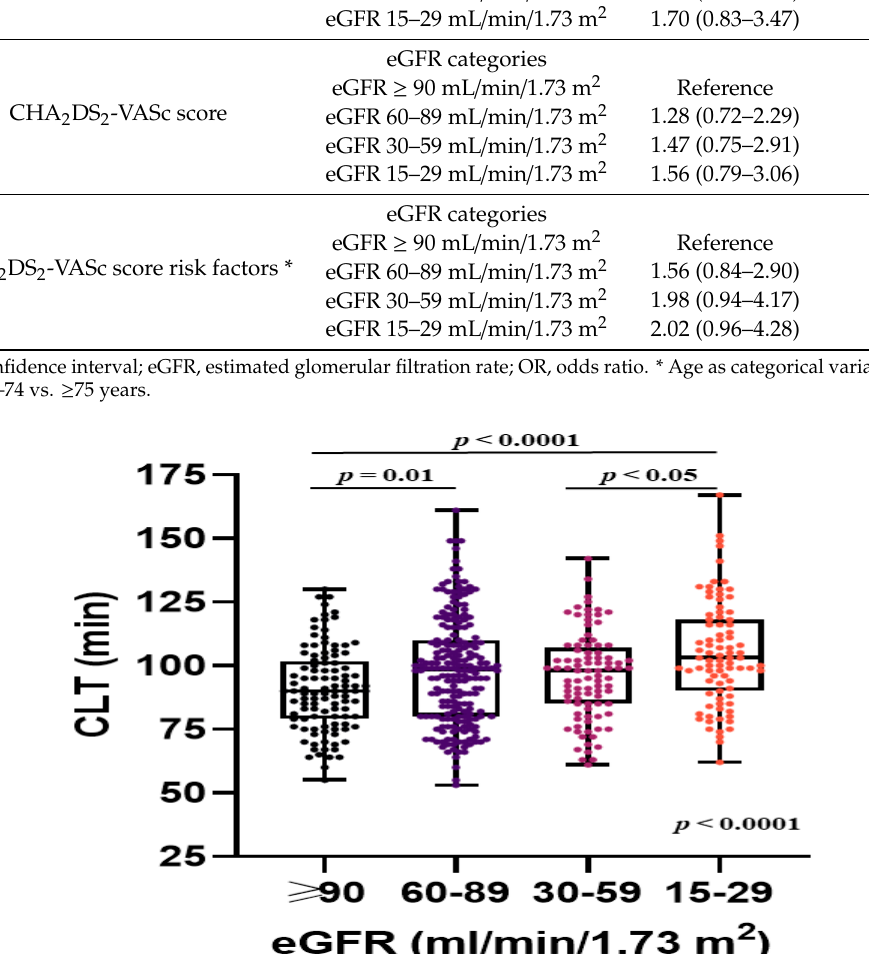
Table 5. Estimated glomerular filtration rate categories as predictors of prolonged clot lysis time (the top quartile, ≥ 108.3 min, n = 125). Adjustment